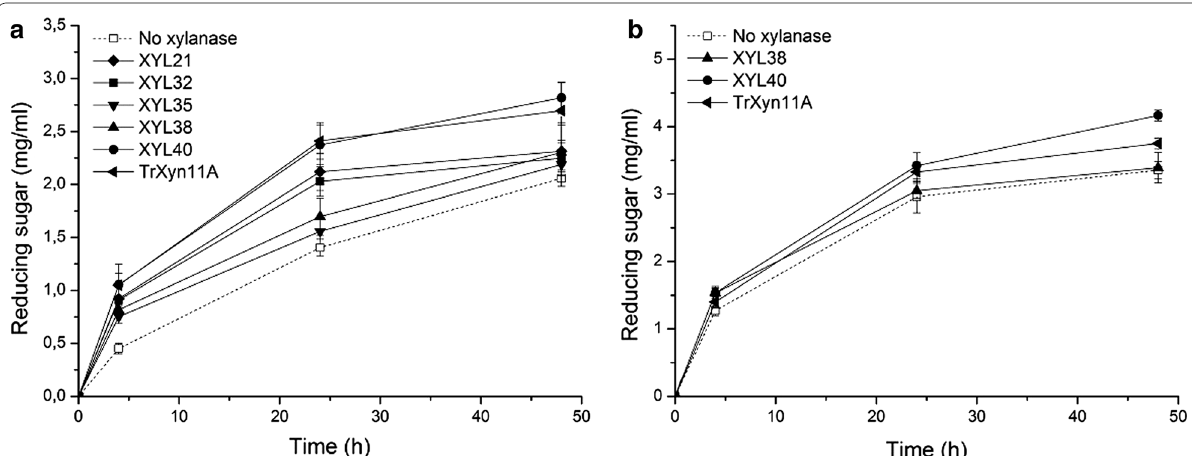
Fig. 5 Hydrolysis of hydrothermally pre-treated wheat straw using novel xylanases as components of multienzyme mixtures. a Hydrolysis at 45 °C using mesophilic enzymes: T. reesei cellulases (TrCel7A, TrCel5A) and A. niger glucosidase (AnCel3A), supplemented with xylanase according to figure inset. b Hydrolysis at 55 °C using thermostable enzymes: CBHI from Acremonium thermophilum (AtCel7A), CBHII from Clostridium thermocellum (CtCel6A) in addition to EGII and β-glucosidase from Thermoascus aurantiacus (TaCel5A and TaCel3A). Xylanase was included according to figure